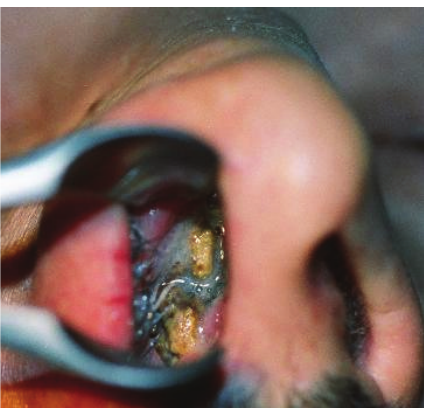
Figure 1: Rhinolith in the right nasal cavity.